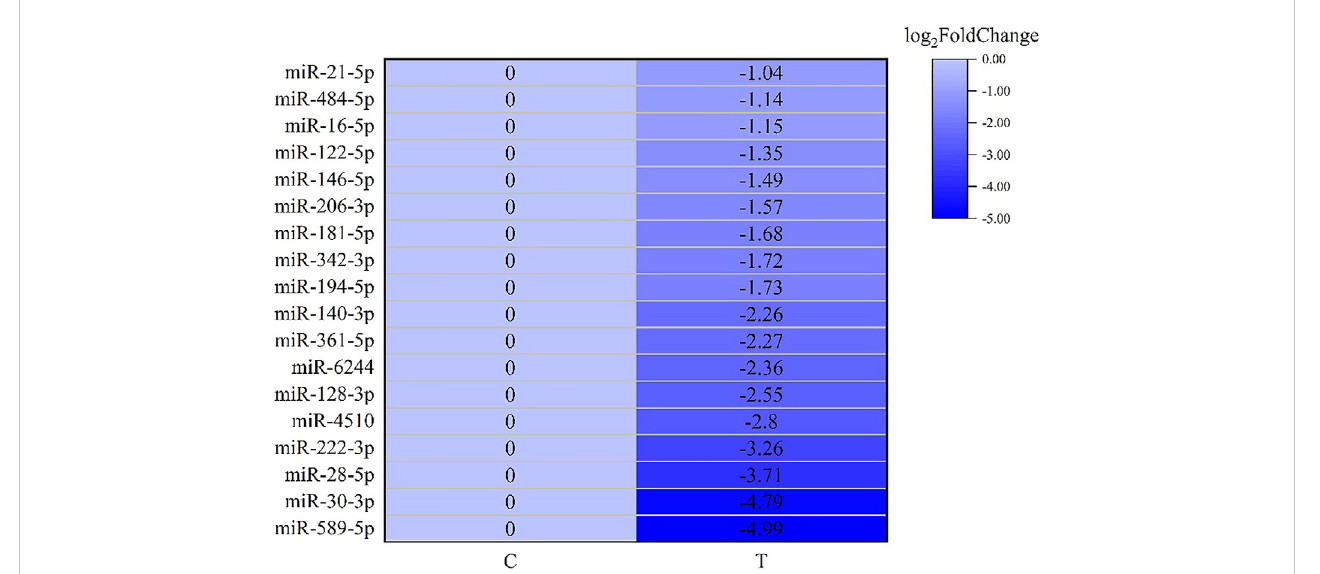
Heat map of predicted target genes of miRNAs involved in the degradation of misfolded protein in ER.